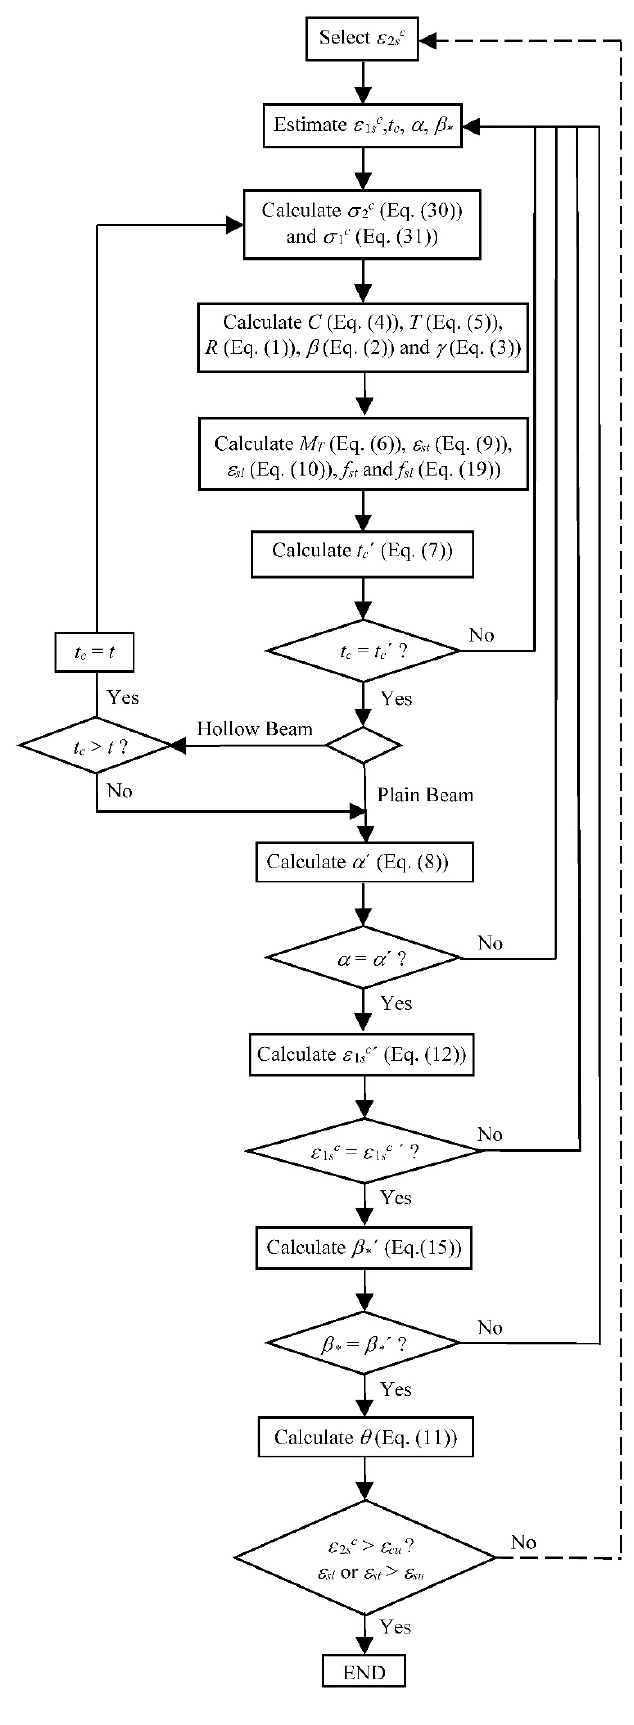
Figure 4. Flowchart. Figure 4.